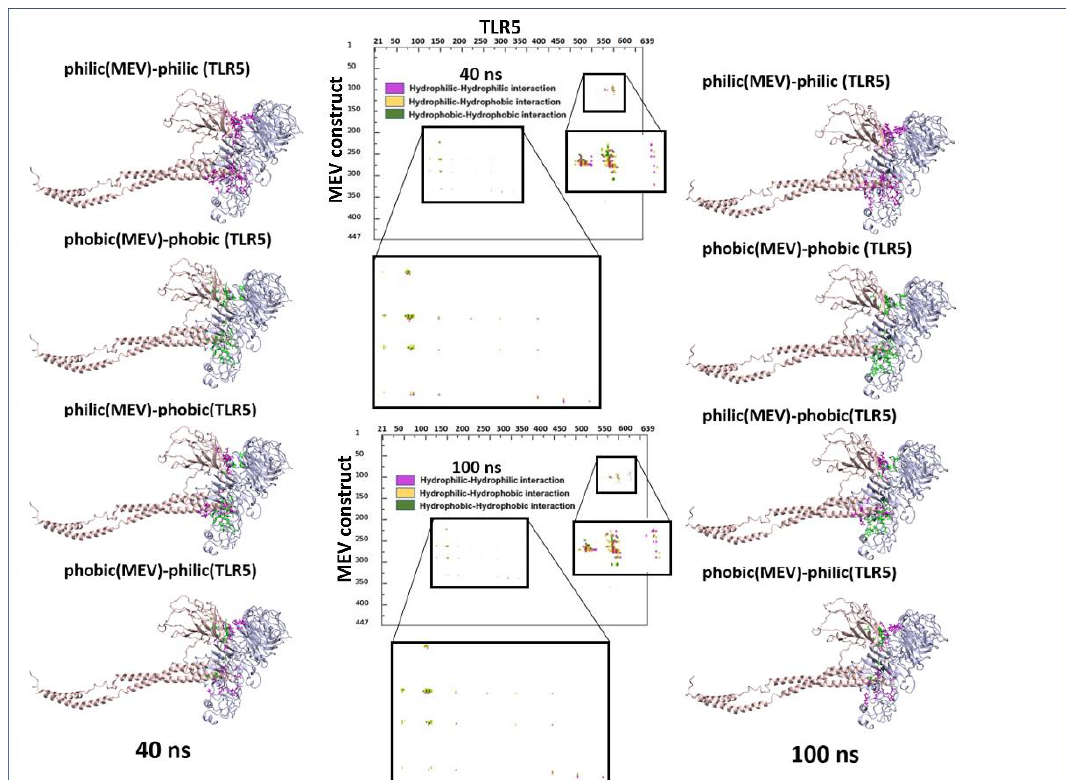
Figure 4. Property contact map of TLR5 and fungal MEV constructs for snapshots at 40 ns and 100 ns. Structures with the highlighted hydrophobic (phobic) and hydrophilic (philic) residues present at the interfaces are shown in green and magenta colors, respectively.